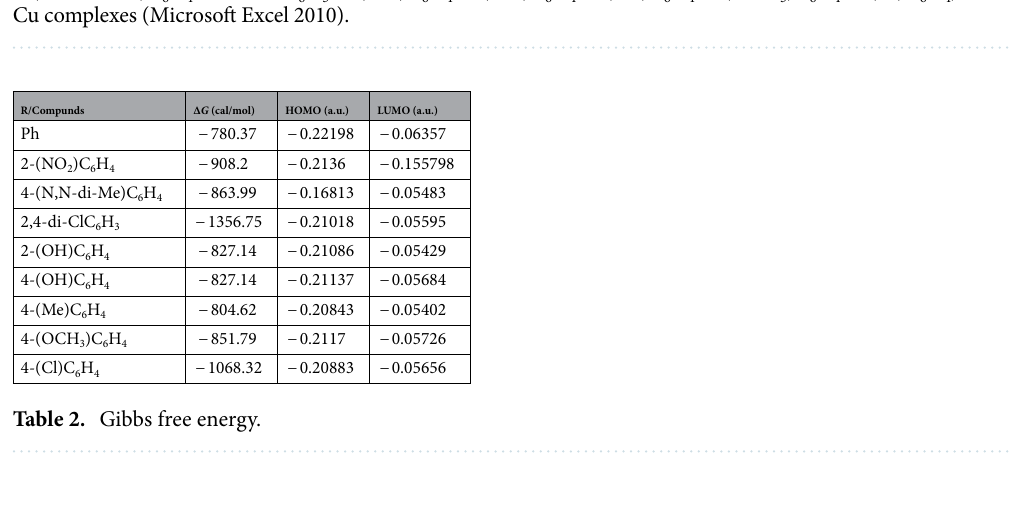
Figure 3. Difference between energy level of pyrazoloquinolines derivatives’ structure (R = Ph, 2-(NO 2 )C 6 H 4 , 4-(N,N-di-Me)C